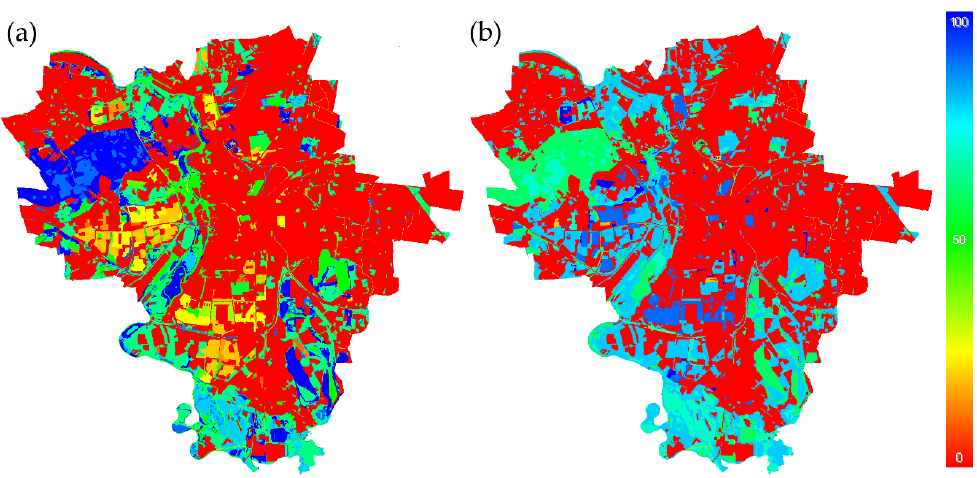
Figure 6. Capacity map for the recreation service “nature experience” ( a ) and “social interaction and leisure activities” ( b ). Value 100 (blue) = highest ecosystem service capacity; 0 (red) = lowest/no ecosystem service capacity.